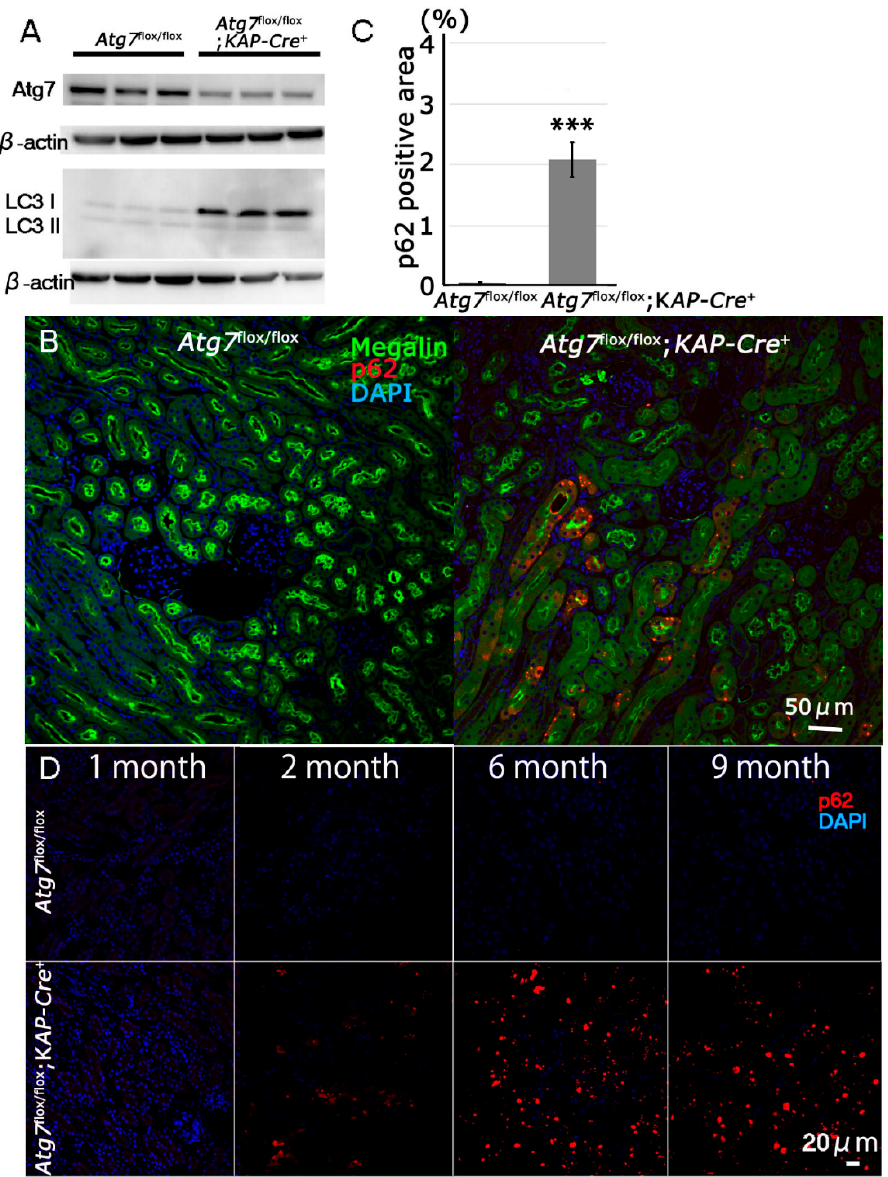
Figure 1. Impairment of autophagy in Atg7 -deficient renal proximal tubular cells. ( A ) Decrease of Atg7 and increase of LC3-I in 2-month-old Atg7 flox / flox ;KAP-Cre + mouse kidney. Atg7 and LC3 Western blot (LC3-I / unconjugated LC3 and LC3-II / lipidated LC3) using whole kidney lysate of Atg7 flox / flox ;KAP-Cre + mice. As a control, Atg7 flox / flox mouse kidney was employed. The intensity of each band of Atg7 and β -actin was estimated by densitometry. The ratio of Atg7 to β -actin was calculated. The amount of Atg7-positive signals in the Atg7 flox / flox ;KAP-Cre + mice kidney was about 63% lower than that in the Atg7 flox / flox mice kidney ( n = 3). Note that LC3-I was increased in the Atg7 flox / flox ;KAP-Cre + mouse kidney. ( B ) The massive accumulation of p62 in kidneys of 2-month old Atg7 flox / flox ;KAP-Cre + mouse. The cortico-medullary region of each kidney in 2 month-old Atg7 flox / flox ;KAP-Cre + mouse and Atg7 flox / flox mouse was recognized with anti-p62 antibody (red). As a marker of renal proximal tubular cells, megalin (green) was employed. Nuclei were stained with 4 ′ ,6-diamidino-2-phenylindole (DAPI; blue). ( C ) Quantification of p62 positive area of 2-month-old Atg7 flox / flox ;KAP-Cre + ( n = 5) and Atg7 flox / flox kidney ( n = 4, *** p < 0.01). Data in graphs are expressed as the mean ± SEM. Statistical analyses were performed using a student’s t -test. ( D ) Age-dependent accumulation of p62 (red) in the Atg7 flox / flox ;KAP-Cre + mouse kidney in 1-, 2-, 6-, and 9-month-old Atg7 flox / flox ;KAP-Cre + (lower) and Atg7 flox / flox (upper) mouse kidney.